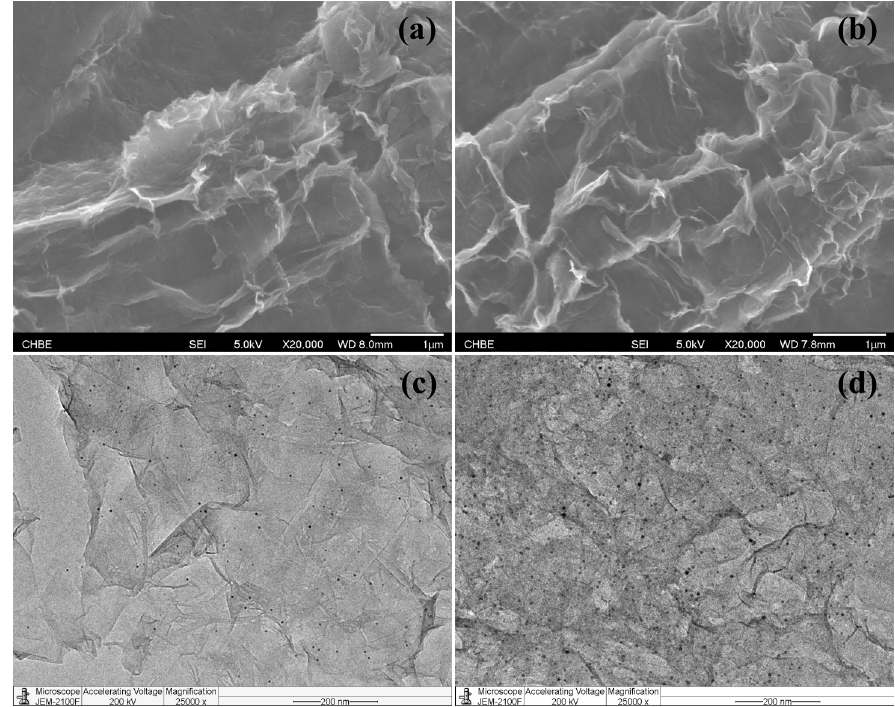
Figure 1. Field emission scanning electron microscopy (FESEM) and transmission electron microscopy (TEM) characterizations of gold/nitrogen-doped graphene (Au/N-rGO) filter at an Au/C ratio of ( a , c ) 0.1% and ( b , d ) 0.2%, respectively.